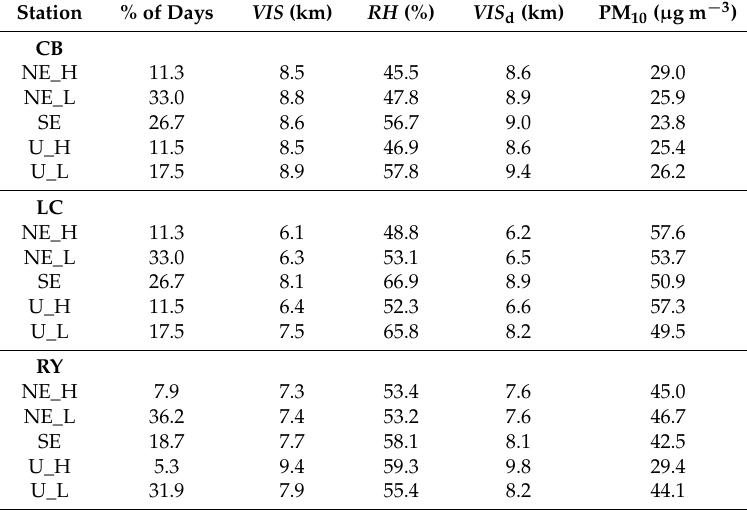
Table 2. Average visibility, RH , RH -corrected visibility, and PM 10 by back-trajectory cluster at stations CB, LC, and